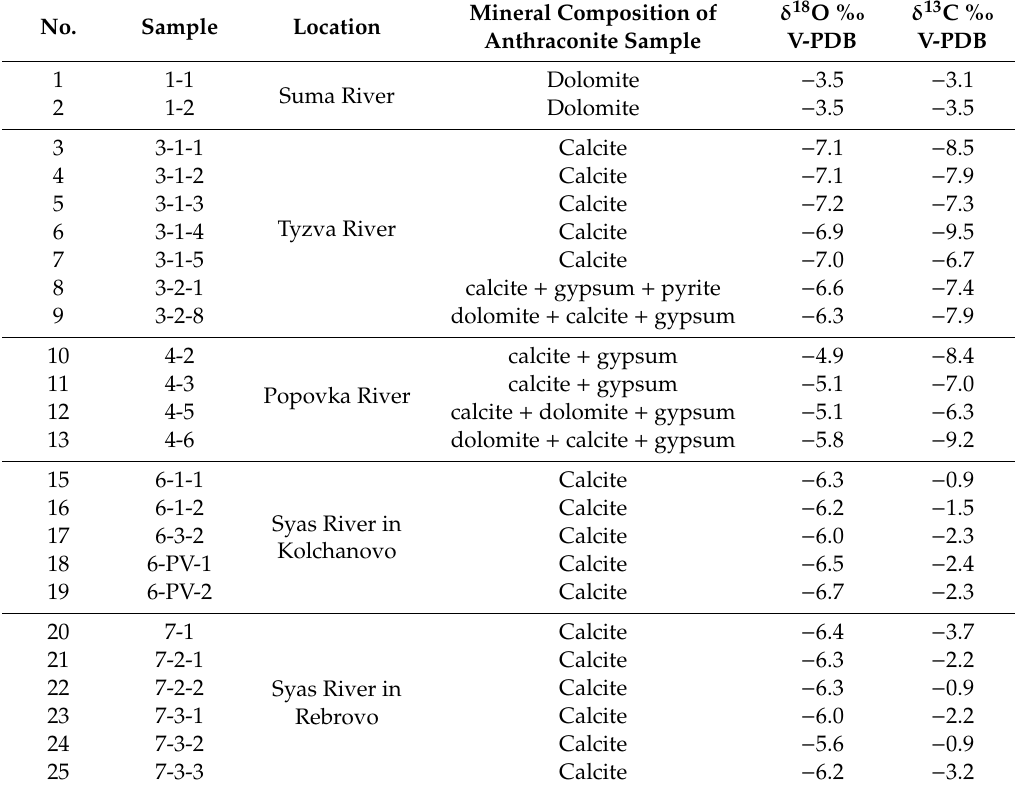
Table 3. Isotopic data from studied anthraconite